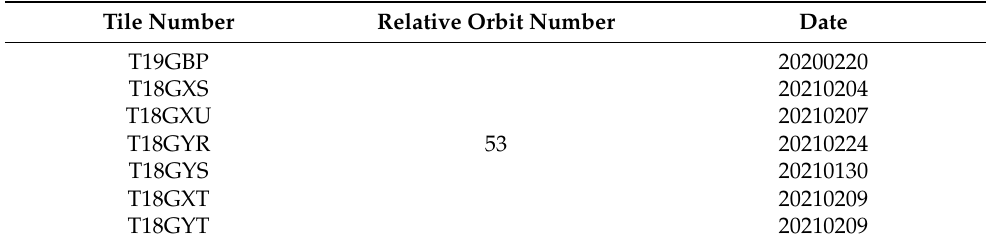
Table 1. Tiles number and dates of Sentinel-2 images used in this work. Tile